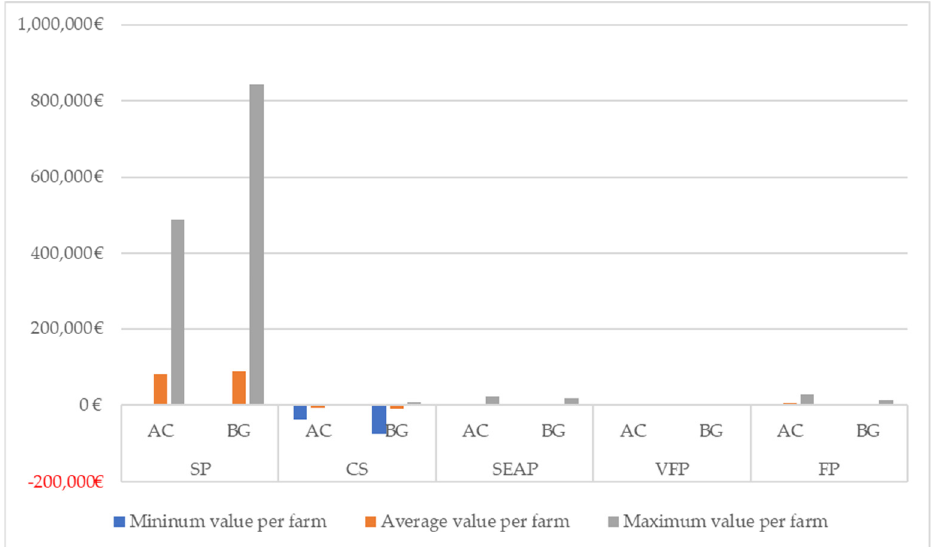
Figure 3. Graphical comparison of the economic values of each ecosystem service per farm. SP—Soil protection; CS—Carbon sequestration; SEAP—Support to extensive animal production; VFP—Vegetal food production; FP—Fiber production; AC—Approach by average class; BG—Buffer generation. Table 4. Total ecosystem services value for all farms in the dataset on aggregate, using the class (AC) and buffer (BG)